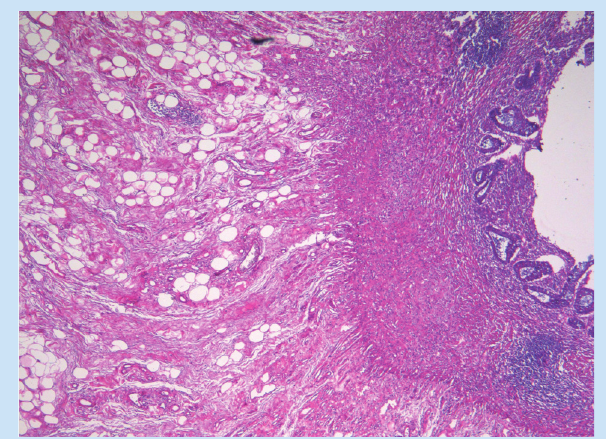
Fig. 3. Microscopy of colonic mucosa demonstrating acute-on-chronic inflammatory infiltrate and submucosal adipose